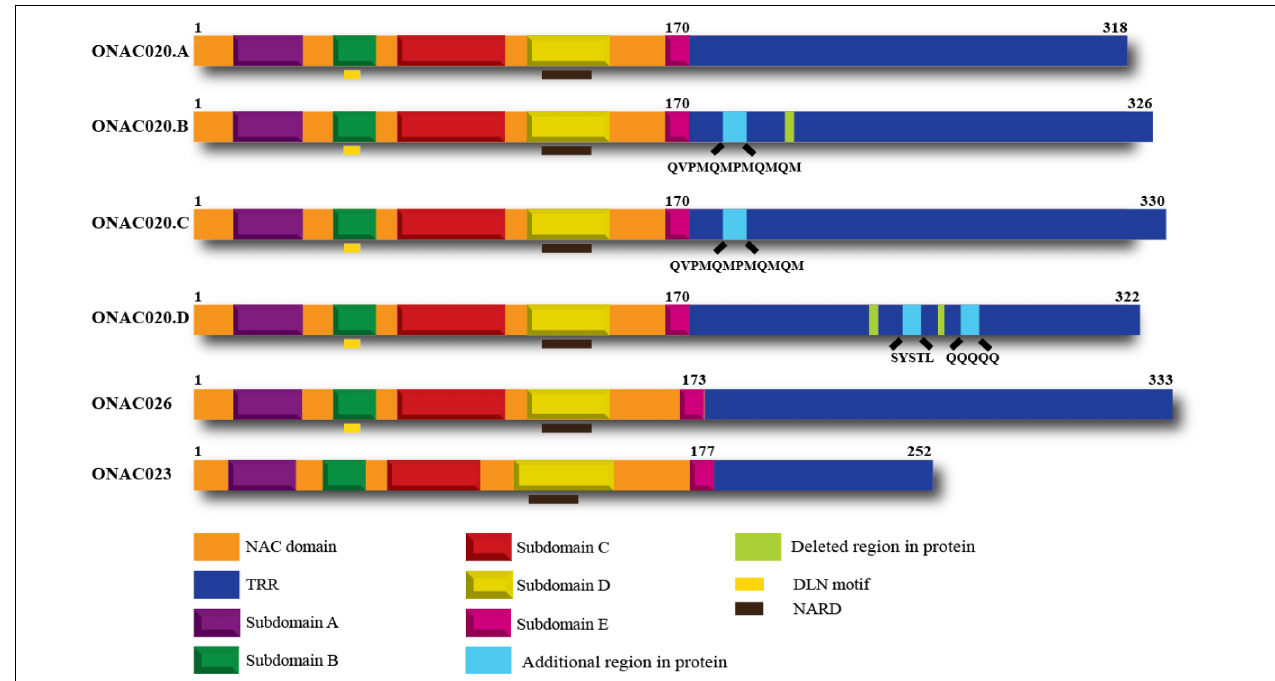
FIGURE 1 | Domains of the three NAC TFs and the different transcript fusion forms of ONAC020. All the proteins have a NAC domain (with subdomains A–E) and a transcriptional regulation region (TRR). ONAC020 and ONAC026 have a putative DLN repressor motif in subdomain B; and all these proteins have a putative NAC repression domain (NARD) in subdomain D. The transcript fusion or trans- splicing between ONAC020 and 026 results in three additional proteins (ONAC020.B, 020.C, and 020.D), with insertions/deletions as marked, with respect to ONAC020.A. The color legend indicating the domains is shown at the bottom of the